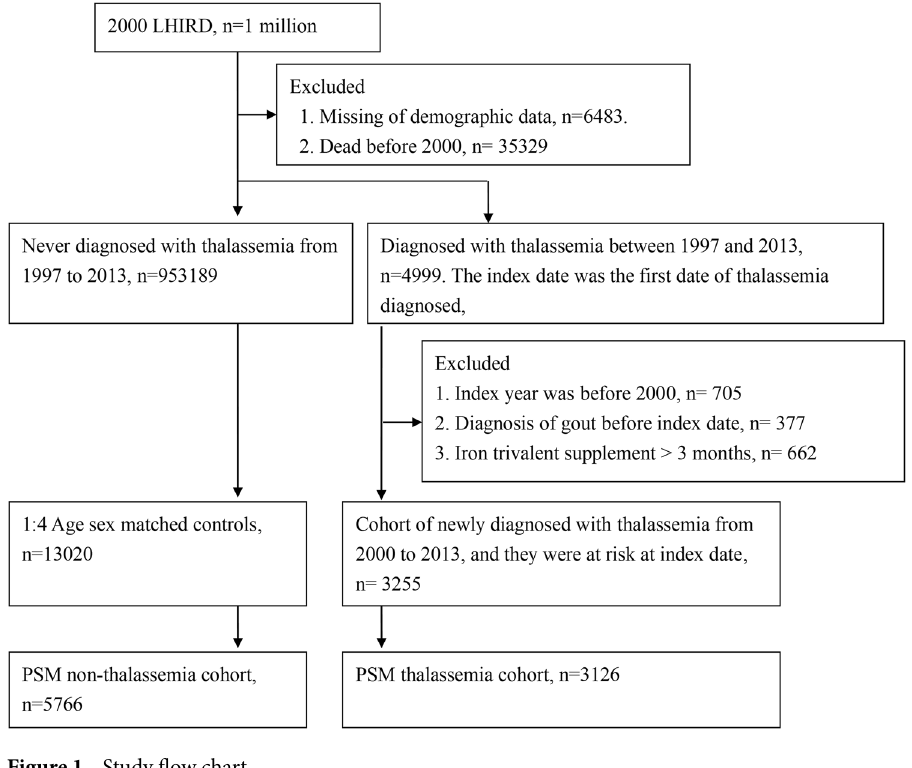
Figure 1. Study flow